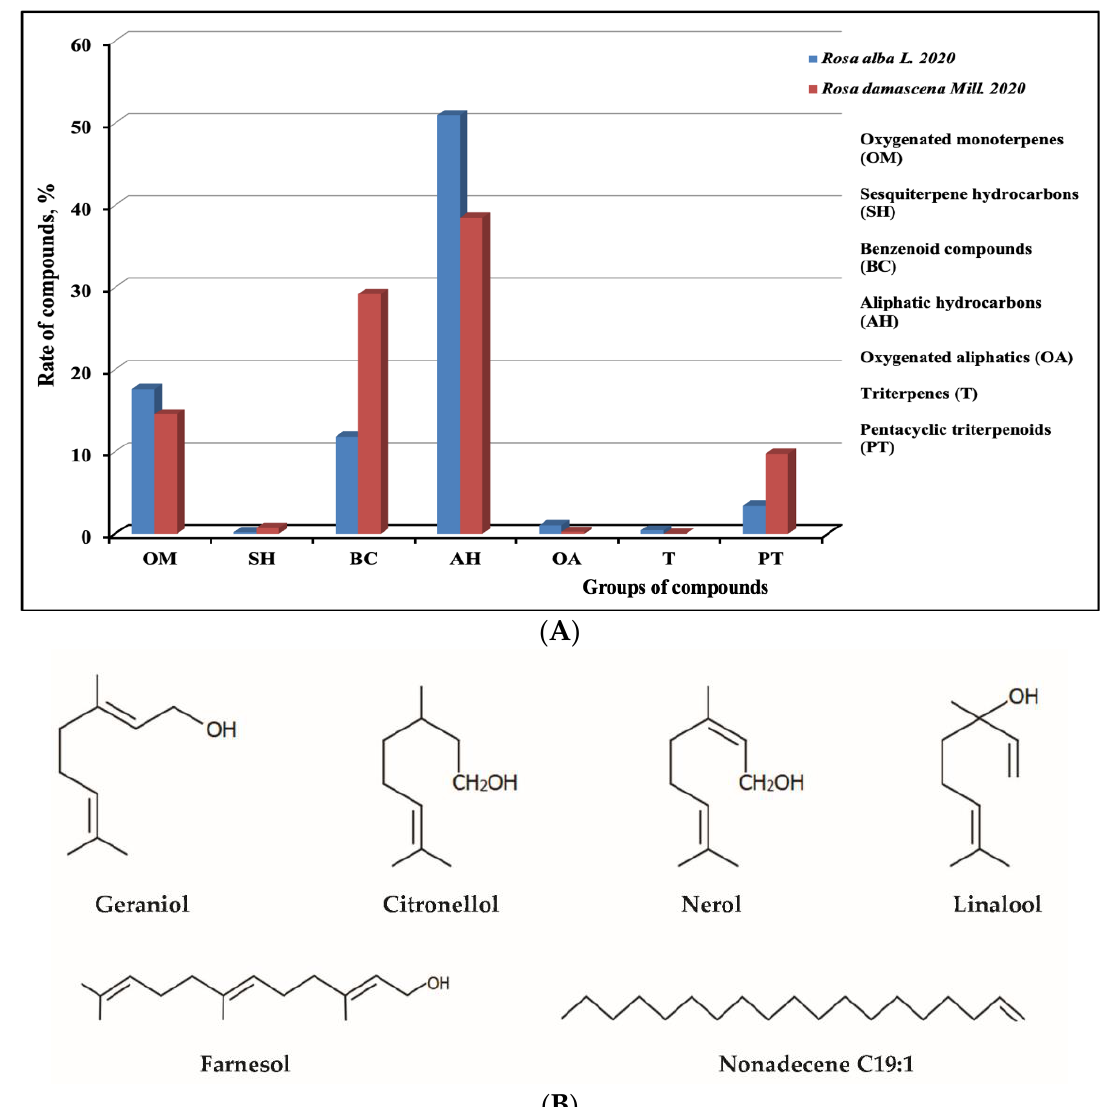
Figure 1. Main groups of compounds containing essential oils of Bulgarian Rosa alba L., and Rosa damascena Mill ( A ). Chemical structure of main ingredients of rose oils ( B ).